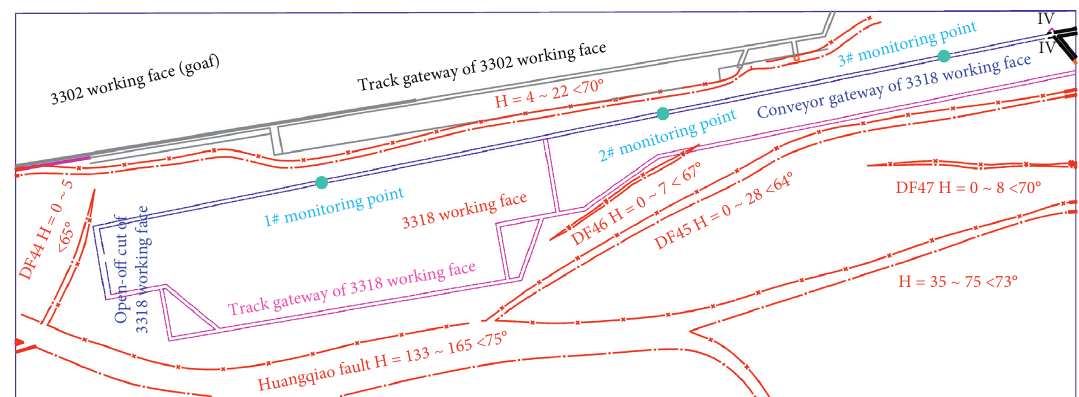
Figure 1: The layout of haulageway of 3318 working